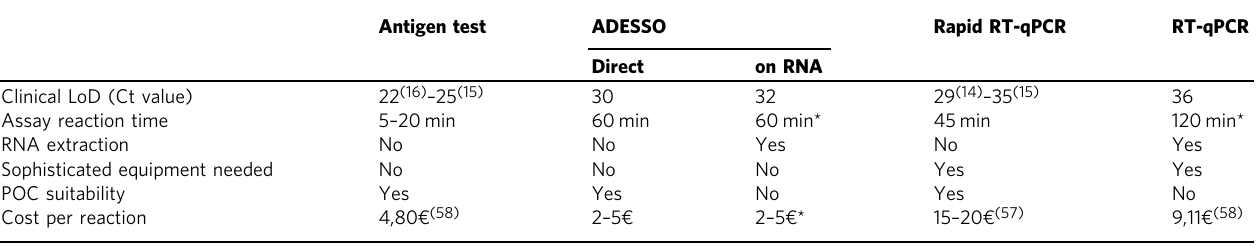
*without RNA In-vitro transcribed SARS-CoV-2 S and Orf1a RNA fragments . These in-vitro transcribed (IVT) fragments were used only in the experiment shown in Supple- mentary Fig. 1c S1D. SARS-CoV-2 RNA, a kind gift of Prof. Bartenschlager (DKFZ, Heidelberg), was used for OneStep RT-PCR (Qiagen, #210212) as follows: 11 μ l of nuclease-free water, 5 μ l of 5× OneStep RT-PCR buffer, 1 μ l of dNTP mix (10 mM each), 1.5 μ l of each primer (forward and reverse, both 10 μ M) and 1 μ l of OneStep RT-PCR Enzyme Mix were added to 4 μ l of denatured RNA. The primers used for the ampli fi cation of SARS-CoV-2 S gene and Orf1a gene are listed in Supplementary Table 6. The RT-PCR protocol was run as follows: retro- transcription at 50 °C for 30 min, denaturation at 95 °C for 15min, followed by 40 cycles of denaturation at 94 °C for 30sec, annealing at 61 °C (Orf1a gene) or 62 °C (S gene) for 30sec and elongation at 72 °C for 5sec. In the end a fi nal elongation step at 72°C was run for 10min. PCR clean-up was performed on the RT-PCR products according to the manufacturer ’ s instructions (Macherey-Nagel, #740609.250). The puri fi ed DNA was in-vitro-transcribed into RNA with the HiScribe T7 Quick High Yield RNA Synthesis Kit (NEB, #E2050S) following the suggested protocol for short transcripts. The IVT products were then treated with DNase I (HiScribe T7 Quick High Yield RNA Synthesis Kit, NEB, #E2050S) and puri fi ed with Monarch RNA Cleanup Kit (NEB, #T2050). The concentration of the puri fi ed products was determined with the Qubit RNA broad range (BR) kit (ThermoFisher Scienti fi c, #Q10211). In order to test SHERLOCK sensitivity, serial dilutions were made in water from a concentration of 1 μ M to 1 aM. Human clinical specimen collection and ethics statement . Clinical specimens were collected at the Medical University Mannheim, Germany. The Ethics